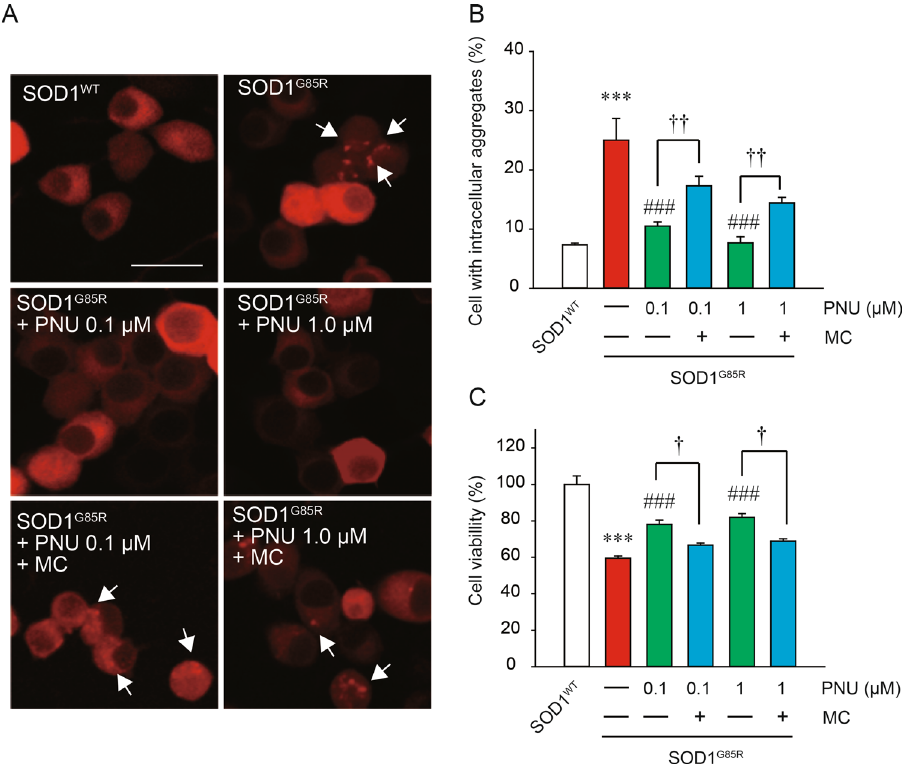
into N2a cells, the cells were treated with 0.1 or 1 µM PNU298987 for 24 h in the presence or absence of 20 µM methyllycaconitine (MC) pretreated before 30 min. ( A ) Representative fluorescent microscopy images. Scale bar: 10 µm. ( B ) Quantified data of intracellular SOD1 aggregates. ( C ) The cell viability was measured by MTT assay. Data is expressed as mean ± SEM from three independent experiments. Significance: *** p < 0.001 vs. SOD1 WT ; ### p < 0.001 vs. SOD1 G85R ; † p < 0.05, †† p < 0.01 vs SOD1 G85R with PNU282987 by One-way